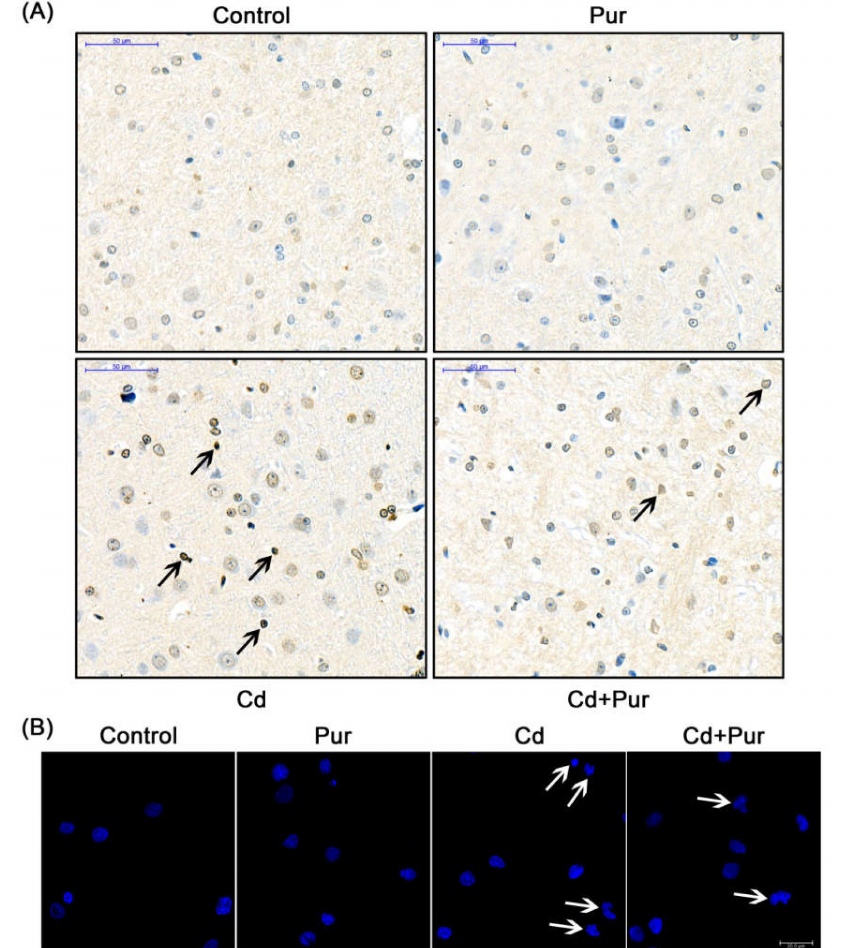
Figure 3. Pur attenuates Cd-induced apoptosis in rat cerebral cortical neurons. ( A ) Rats were treated with Cd (50 mg/L) and/or Pur (200 mg/kg) for 90 days. Apoptosis in the cerebral cortex was detected by a TUNEL assay. The TUNEL-positive cells were dark red (marked by black arrows). Scale bar: 50 µ m. ( B ) Primary cortical neurons were pretreated with 100 µ M Pur for 1 h, followed by 10 µ M Cd exposure for 12 h. The morphology of the apoptotic cell nuclei was detected by DAPI staining (arrows point to apoptotic cells). Scale bars: 20 µ